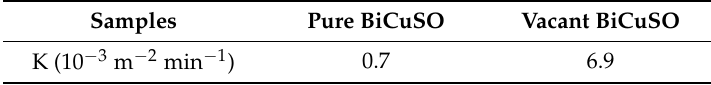
Figure 3. ( a ) Degradation rate of Congo Red aqueous solution with pure BiCuSO and vacant BiCuSO as catalysts under visible light over 80 min; ( b ) cycling runs using BiCuSO powders under light irradiation. Table 2. Specific surface area and reaction rate constant of as-prepared